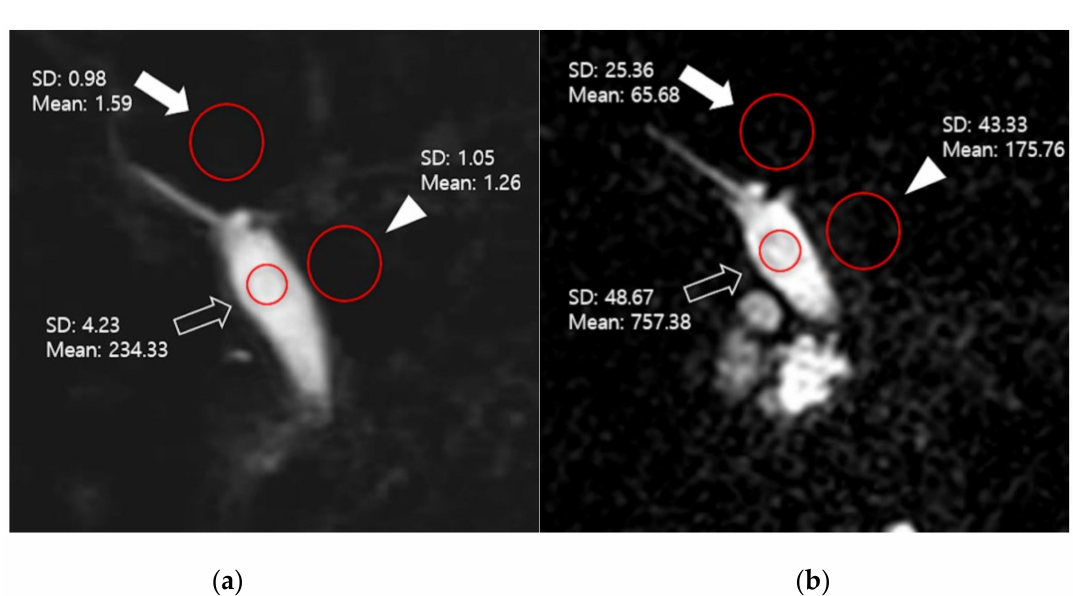
Figure 1. A representative slice of breath-holding (BH)-CS-compressed sensing MRCP (MRCP) ( a ) and BH- gradient and spin-echo MRCP (GRASE-MRCP) ( b ) used for quantitative analysis (upper CBD: hollow arrow, periductal tissue: arrowhead, liver: solid arrow). The mean value of regions of interest (ROI) (red circles) represents signal intensity (SI), and standard deviation (SD) was used as image noise. Signal-to-noise ratio, contrast ratio, and contrast-to-noise ratio were 45.26, 0.98, 62.4 on BH-CS-MRCP ( a ), and 23.15, 0.69, 23.61 on BH-GRASE-MRCP ( b ),